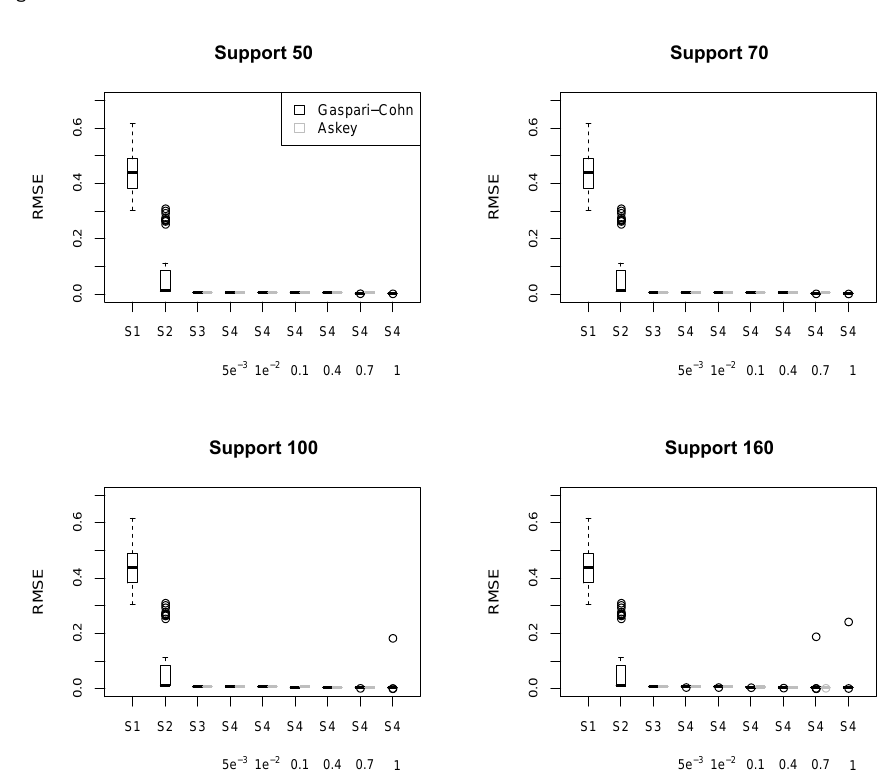
Figure 9. Same as Fig. 5 but for 500 ensemble members.